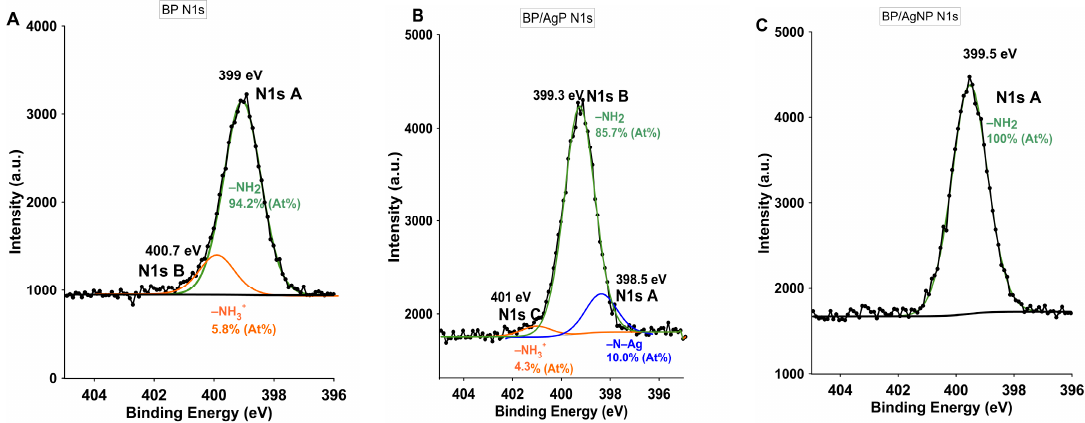
Figure 3. High-resolution XPS spectrum for the N1s core level for ( A ) BP, ( B ) BP/AgP, and ( C ) BP/AgNP.